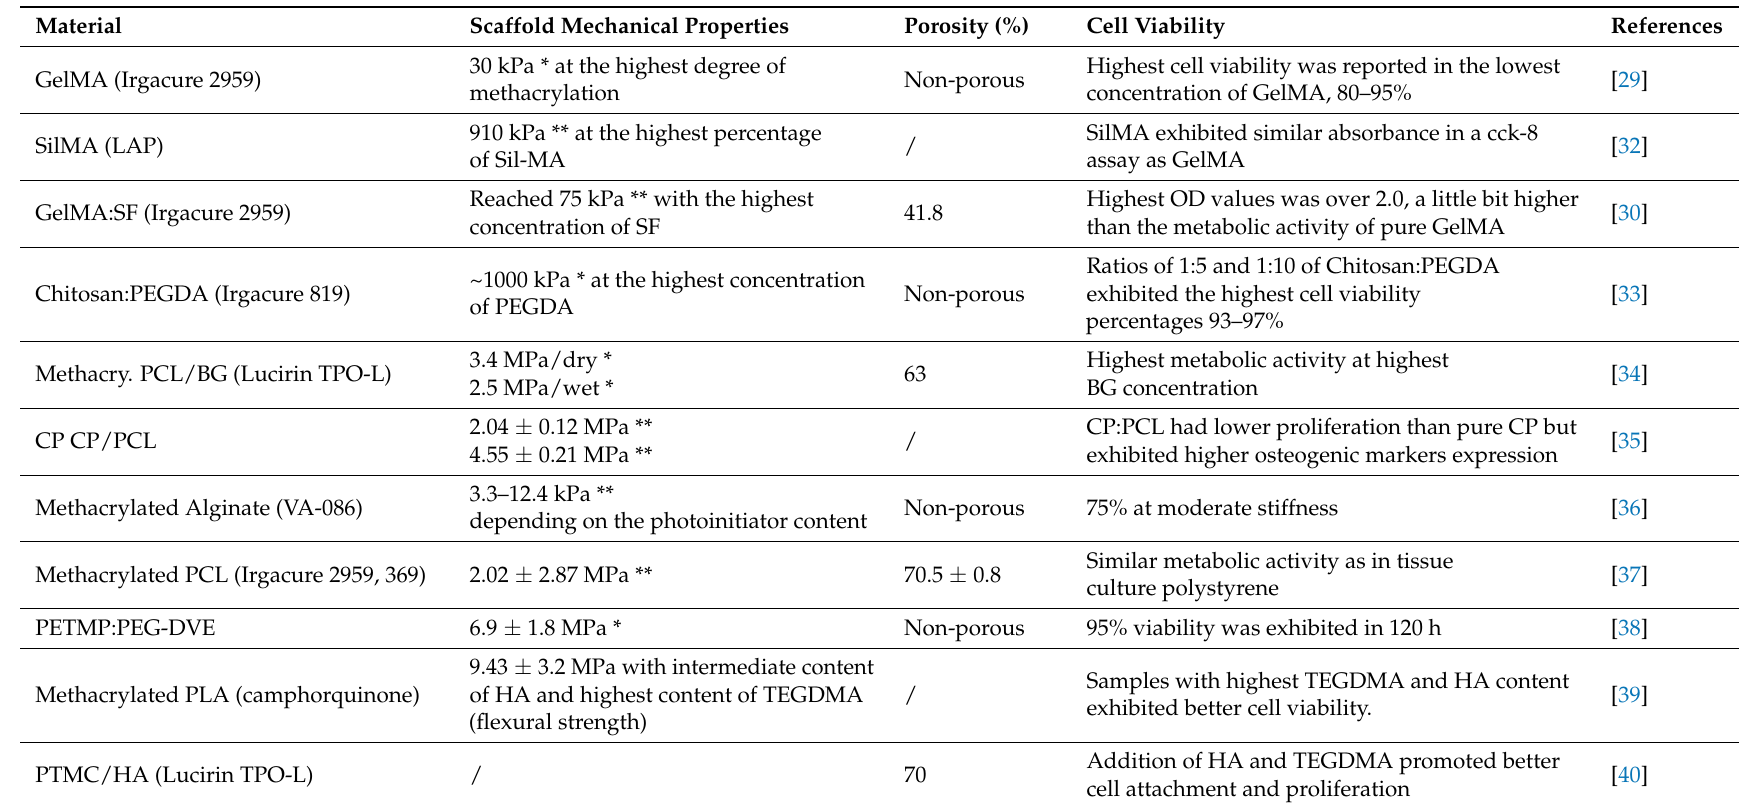
Table 1. Summary of SLA Scaffold